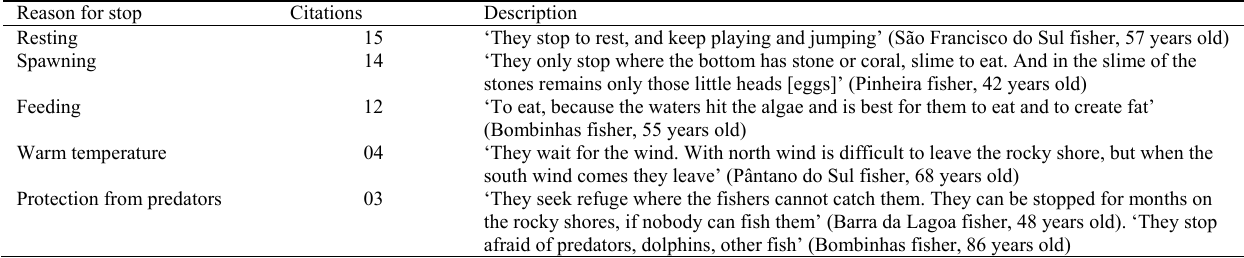
Table 3. Reasons for mullet ‘ paradas ’ (stops) in rocky shores, islands, beaches and open sea, according to 29 key-informant fishers from Santa Catarina State (Brazil) knowledgeable of such ecological traits.